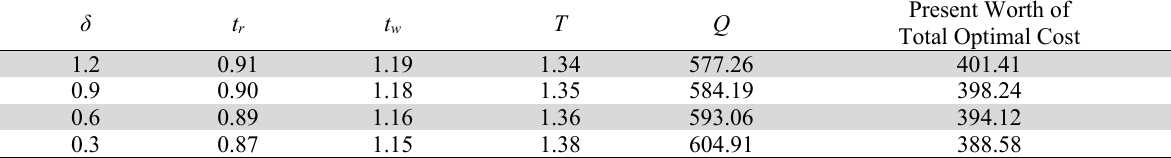
Impact of δ on the optimal replenishment